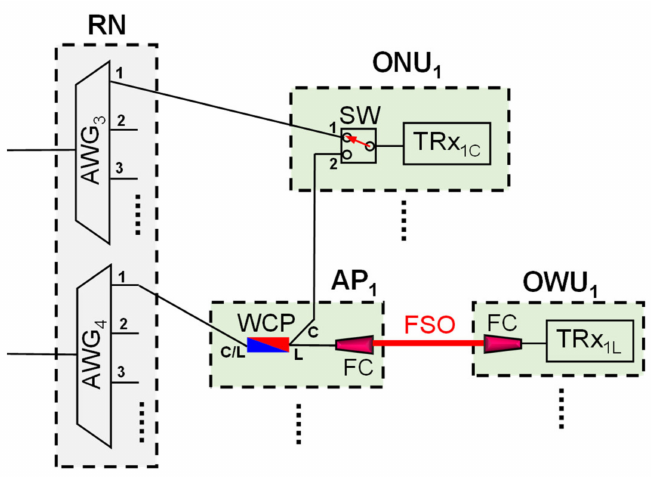
Figure 4. The new designed architectures of RN, ONU, AP and OWU in the hybrid fiber-FSO WDM-PON